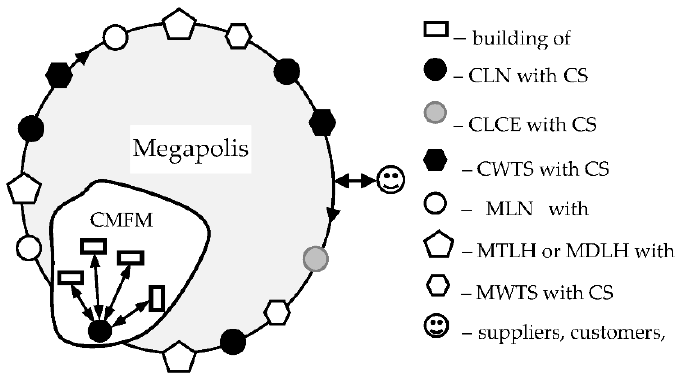
Figure 1. CMFMC with CLN and other logistics facilities in the structure of a